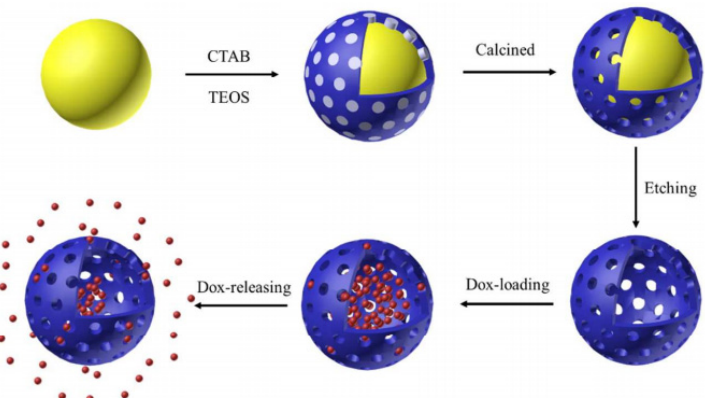
Figure 6. Schematic illustration of the preparation of hollow mesoporous silica used for drug loading and drug releasing. Reproduced with permission from Ref. [105], Copyright 2017, American Chemical Society.